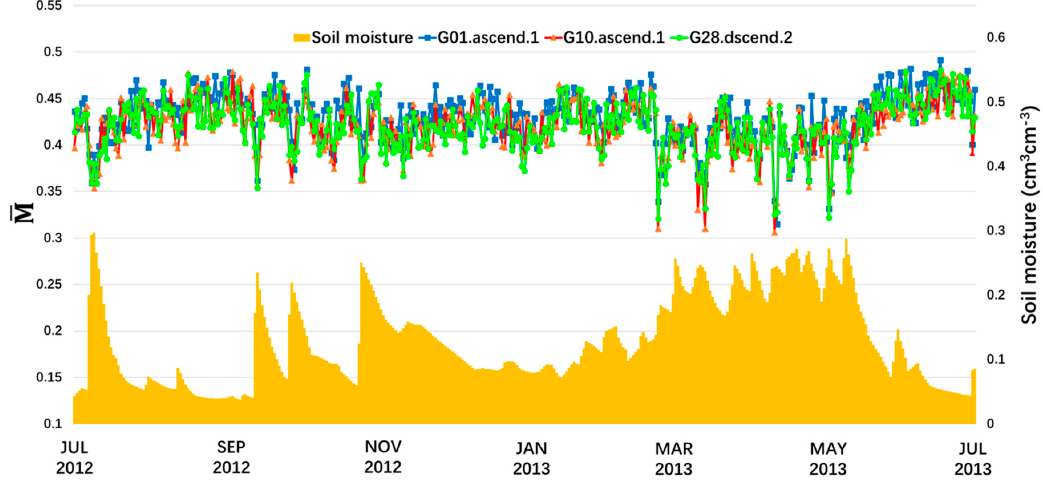
Figure 6. Three M time series of di ff erent Figure 6. Three M ̅ time series of different satellites.